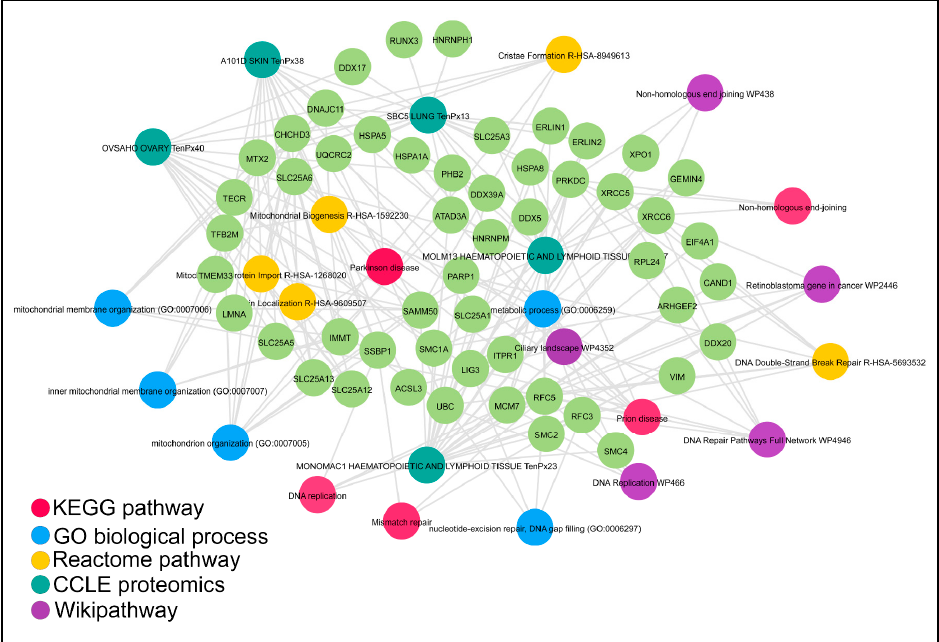
Figure 6. The interaction of RUNX3 with DNA replication and DNA repair factors in the absence of exogenous DNA damage. The SILAC mass spectrometry methodology was used to dissect the RUNX3 interactome in the absence of exogenous DNA damage. The list of RUNX3 interacting pro- teins from Tay et al., [60], Table S1, was analyzed using the EnrichR database [80]. Proteins indicated within green circles were retrieved as RUNX3-interacting proteins in co-immunoprecipitation studies. For the complete list of RUNX3-interacting proteins, please refer to [60].